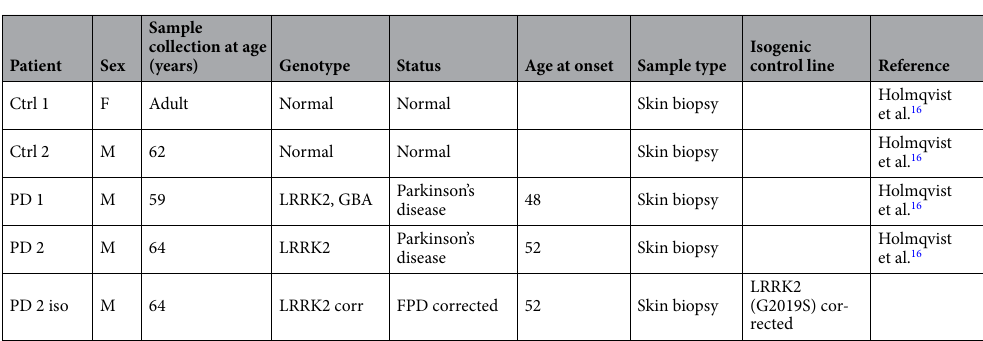
Table 1. Summary of healthy control and PD patients used in this study. iPSC induced pluripotent stem cell, Ctrl control, F female, M male, LRRK2 leucine-rich repeat kinase 2, GBA acid beta-glucosidase, FPD familial Parkinson`s